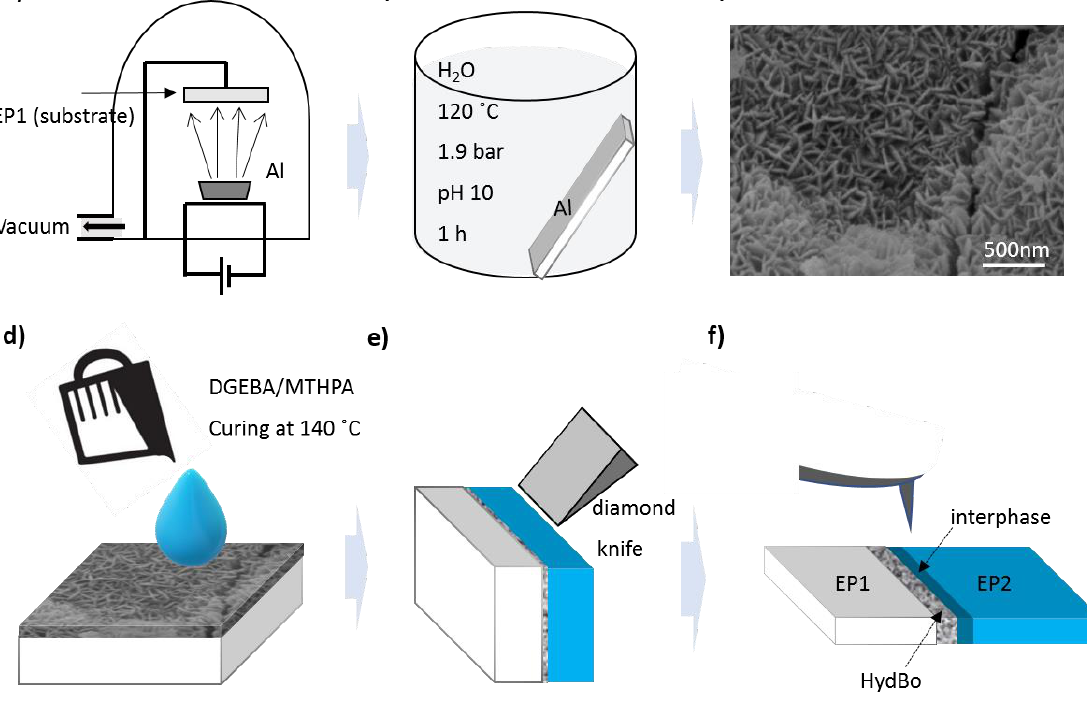
Figure 1. Schematic of the preparation of pre-cured epoxy substrate (EP1), hydrothermally synthesized boehmite (HydBo) and interactive epoxy surface (EP2) model sample. ( a ) Physical vapor deposition of aluminum on the epoxy substrate EP1, ( b ) Hydrothermal synthesis of the boehmite layer from the aluminum coating in distilled water, ( c ) Top view scanning electron microscope (SEM) image of the hydrothermally synthesized boehmite (HydBo), ( d ) Preparation of the interacting epoxy layer, ( e ) Ultramicrotomy of the cross-sectional surface of the layered structure. ( f ) Evaluation of the microtomed sample with atomic force microscopy (AFM)-based and SEM / EDS methods.